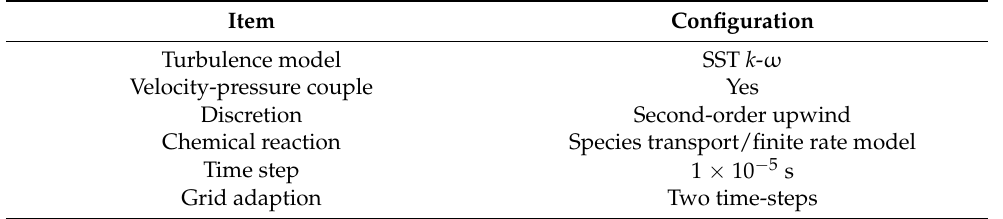
Table 3. Configurations of the 2D model.